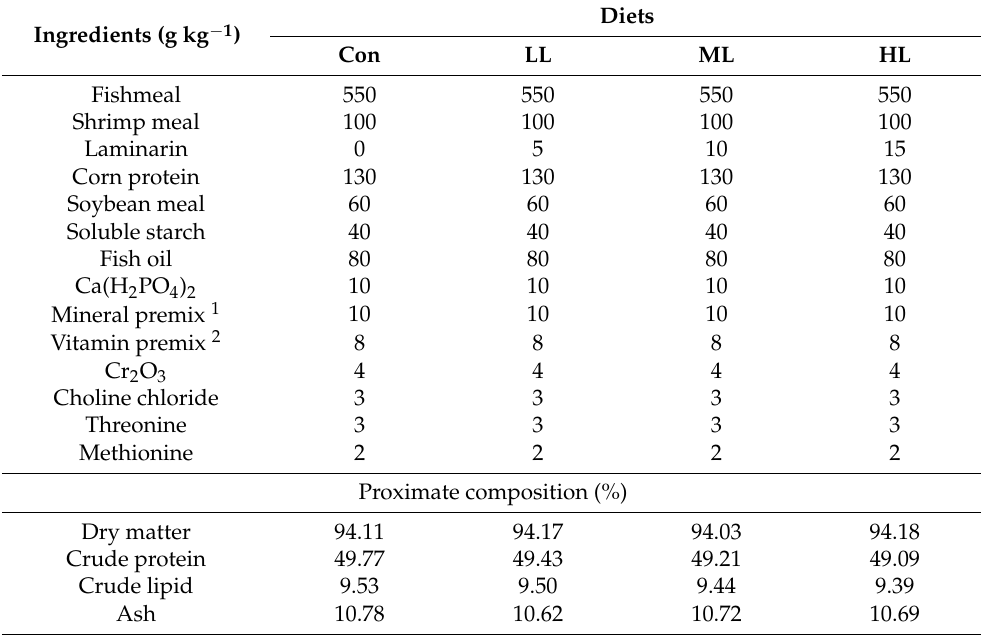
Table 1. Formulation and proximate composition of the experimental diets